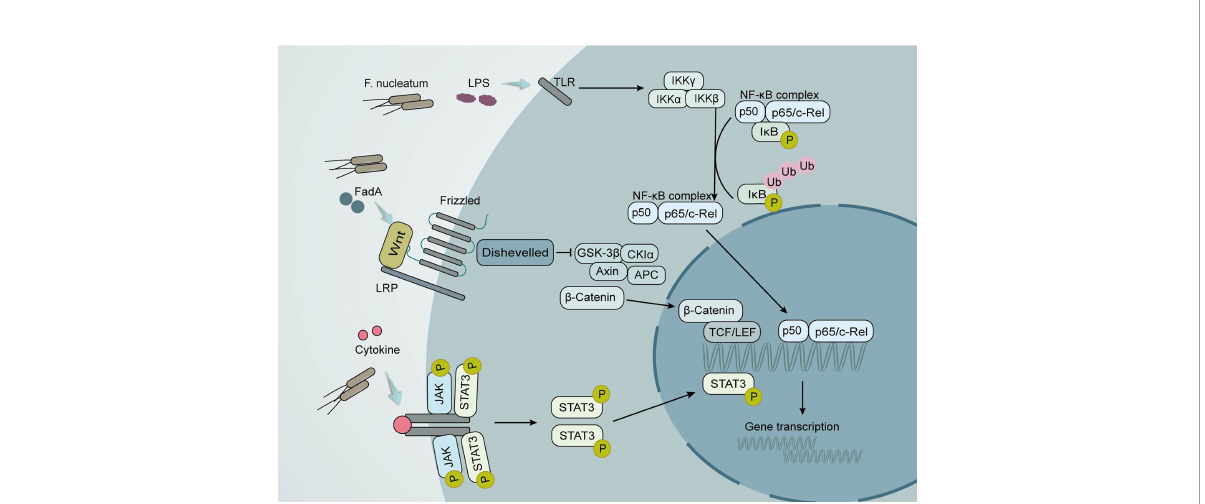
FIGURE 2 Local effects of the gut microbiota on CRC development. Clostridium nucleatum promotes tumor development through multiple mechanisms. Its production of the virulence factor FadA can lead to increased expression of membrane-linked protein A1 via E-calmodulin, which in turn activates Wnt/ b -linked protein signaling. The wnt ligand, a secreted glycoprotein, can bind to coiled-coil receptors and form larger cell surface complexes with lipoprotein receptor-associated protein (LRP). Displacement of the multifunctional kinase GSK-3 b from the regulatory APC/Axin/GSK-3 b complex is triggered by the activated Wnt receptor complex. The stable b -linked protein translocates to the nucleus, displaces the co-inhibitor upon binding to LEF/TCF transcription factors, and recruits the coactivator. Lipopolysaccharide (LPS) in F. nucleatum causes the activation of the nuclear factor k light chain enhancer (NF- k B) signaling pathway in activated B cells. The conventional signaling pathway is that NF- k B/Rel proteins bind to and are inhibited by I k B proteins. Lipopolysaccharide (LPS) activates IKK complexes (IKK b , IKK a , and IKK g ) via toll-like receptors (TLR) to phosphorylate I k B proteins. I k B phosphorylation leads to its ubiquitination and proteasomal degradation followed by release of NF- k B/Rel complexes. The active NF- k B/Rel complex is further translocated into the nucleus and induces target gene expression. Another important signaling pathway that activates cytokines is the Janus kinase/signal transducer and activator of transcription (JAK-STAT) pathway. When STAT is phosphorylated, it polymerizes into an activated form of transcriptional activator and enters the nucleus to bind to target genes and promote their